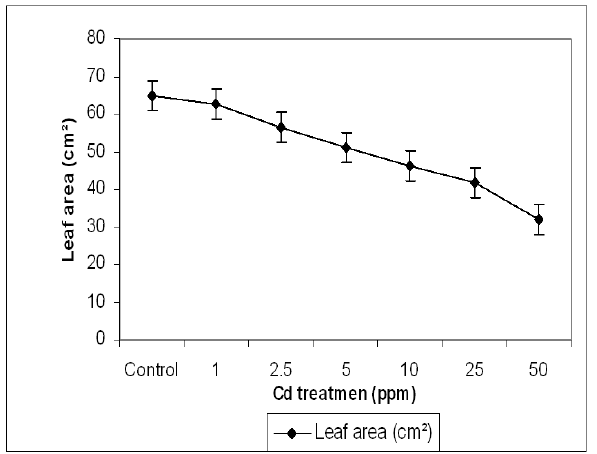
Fig. 2. Levels of chlorophyll and carotenoid contents (mg g -1 leaf ) on the 2 FW) of Cd treated radish plants grown in sand culture at the harvest time (40 days). FW: fresh weight